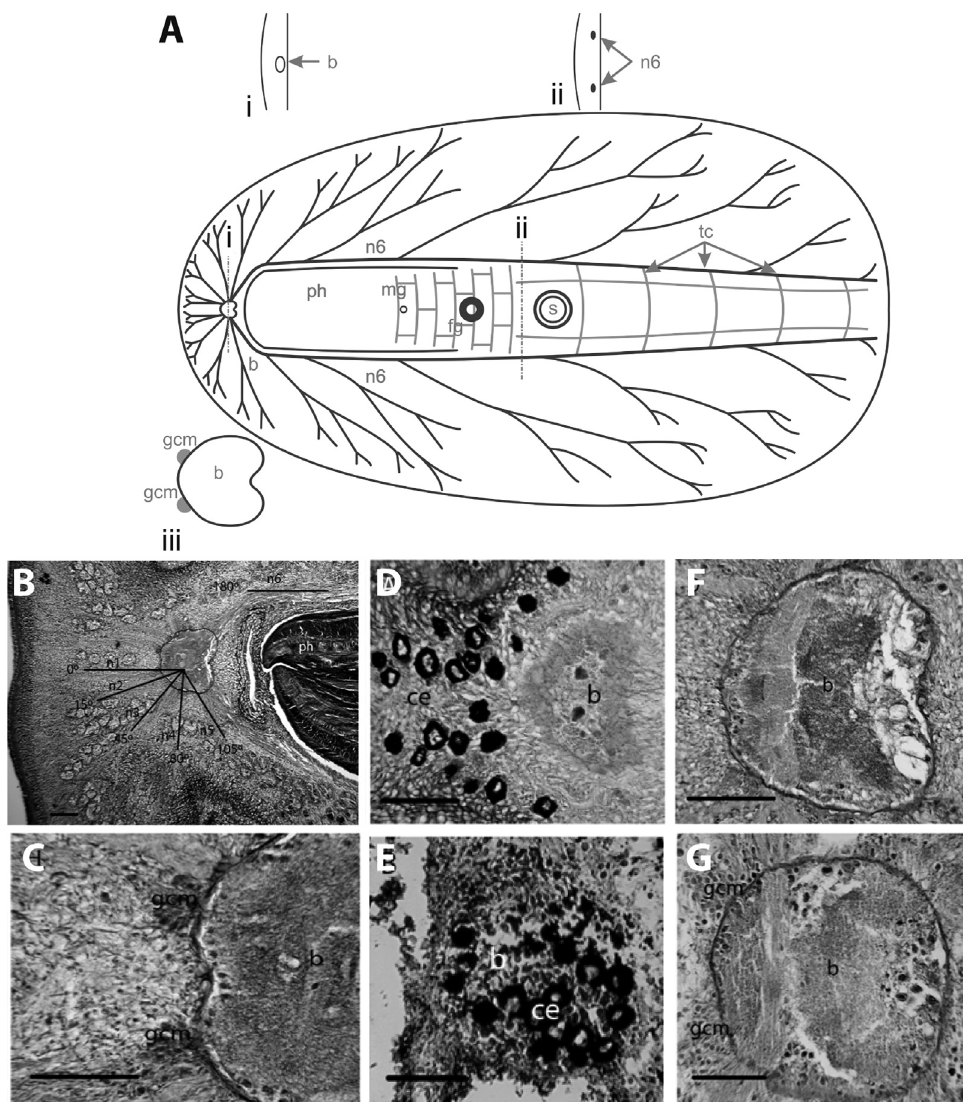
Figure 2 - Polyclad nervous system organization: Category II. A. Schematic representation includes cross sections at the level of the brain (i) and at the level of the n6 nerve pair (ii); detail of the brain is shown below (iii). B. Longitudinal section through the anterior region of Enchirium periommatum showing the distribution of the main ventral nerve cords. Scale bar 250 (cid:2) m. C. Anterior portion of the E. periommatum brain, showing the poor develop- mentoftheglobulicellmasses.Scalebar100 (cid:2) m. D. Arrangementofthecerebraleyesin E.periommatum .Scalebar100 (cid:2) m. E. Arrangementofthecere- bral eyes in Pseudoceros bicolor . Scale bar 100 (cid:2) m. F. Brain shape in E. periommatum . Scale bar 100 (cid:2) m. G. Brain shape in Pseudoceros bolool . b brain,